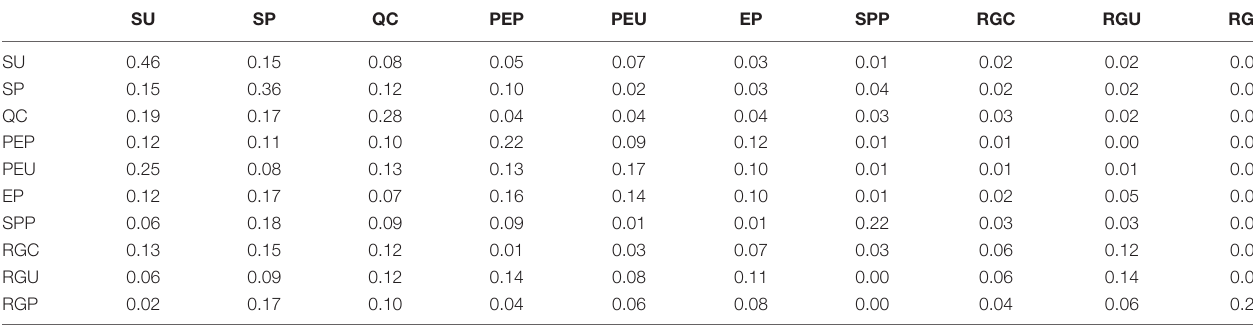
TABLE 6 | The transition matrix of the 10 most occurring states in discourse sessions.